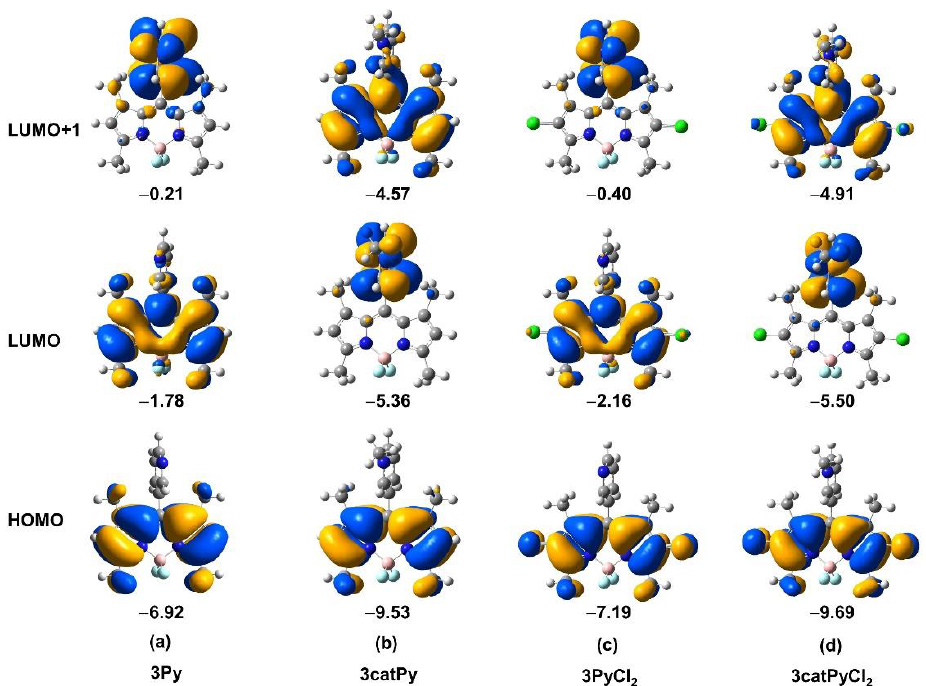
Figure 5. Frontier orbitals of ( a ) 3Py , ( b ) 3catPy , ( c ) 3PyCl 2 and ( d ) 3catPyCl 2 BODIPYs. Orbital energies in eV. The frontier orbitals for the entire series are given in Appendix A.